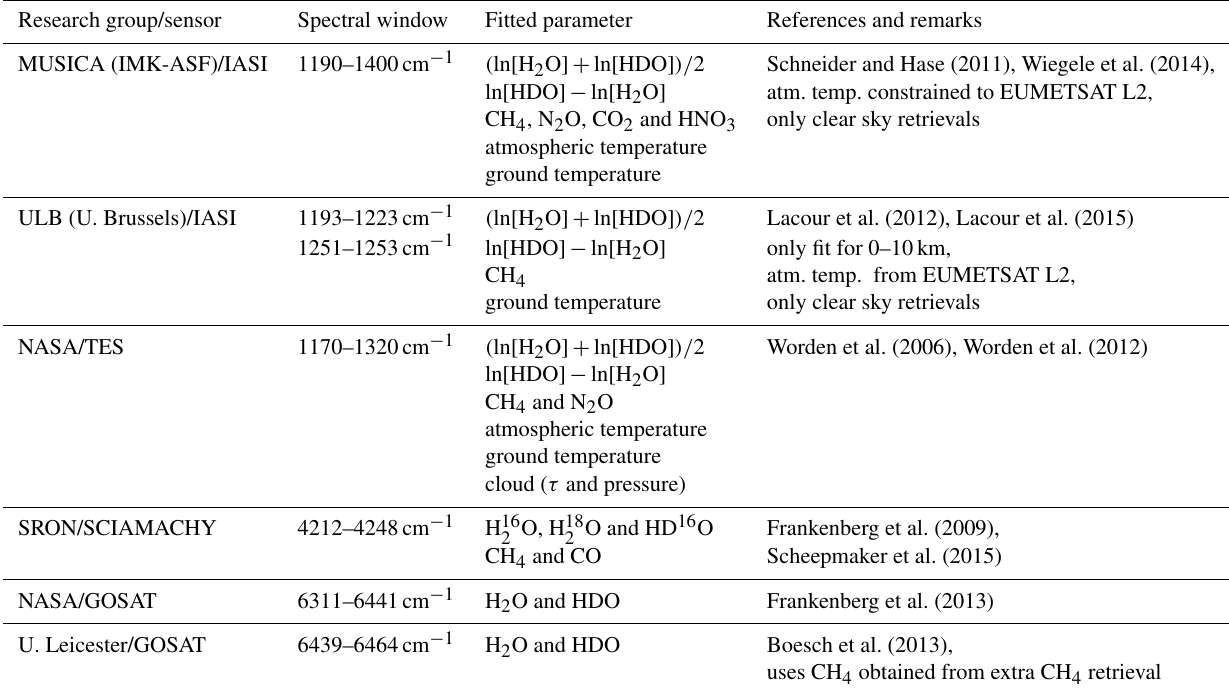
Table B1. Overview of tropospheric water vapour isotopologue retrievals using space-based observations.